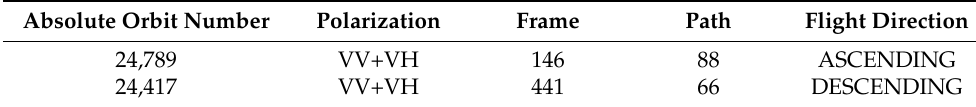
Table 2. SAR stacks parameters